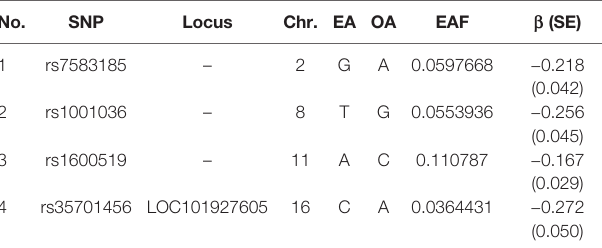
TABLE 2 | List of genetic instruments for anti-cytomegalovirus igg levels by each instrumental SNP (GWAS signi fi cance with p < 5 × 10 − 7 and linkage disequilibrium threshold with R 2 < 0.001).